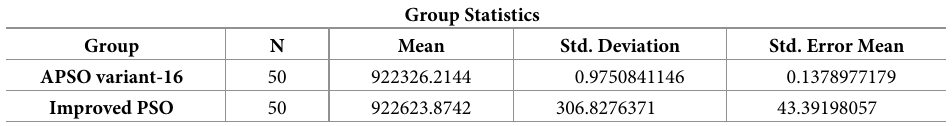
Table 10. Group statistics of independent sample t-test for the CSTHTS